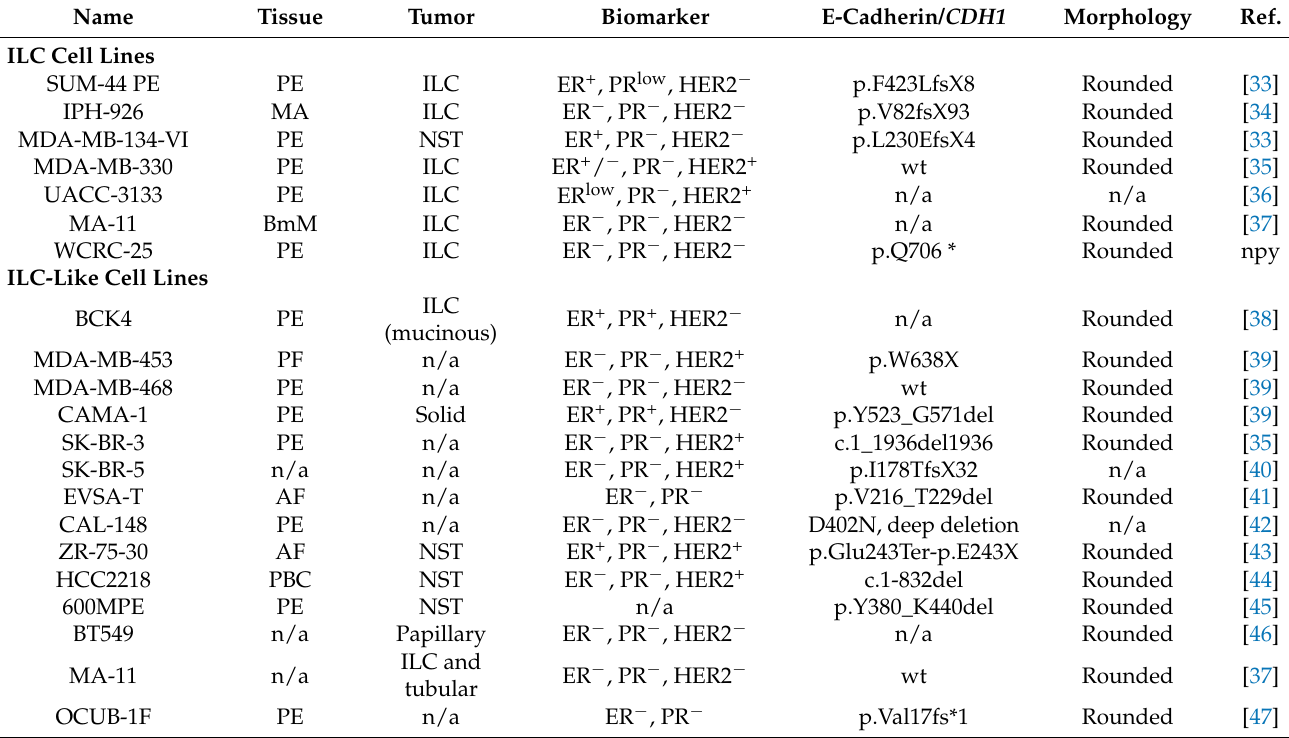
Table 2. ILC and ILC-like cell lines. Information was collected from published literature. Widely used ILC and ILC-like breast cancer cell lines. Abbreviations: MA, malignant ascites; PF, pericardial fluid; BM, bone metastasis; OvM, ovarian metastases; ER, estrogen receptor; NST, non-special type; PE, pleural effusion; BmM, bone marrow metastases; n/a, not available; Ref, reference(s); *, premature termination (stop) codon; npy, not published yet. See also expanded table at Supplemental File